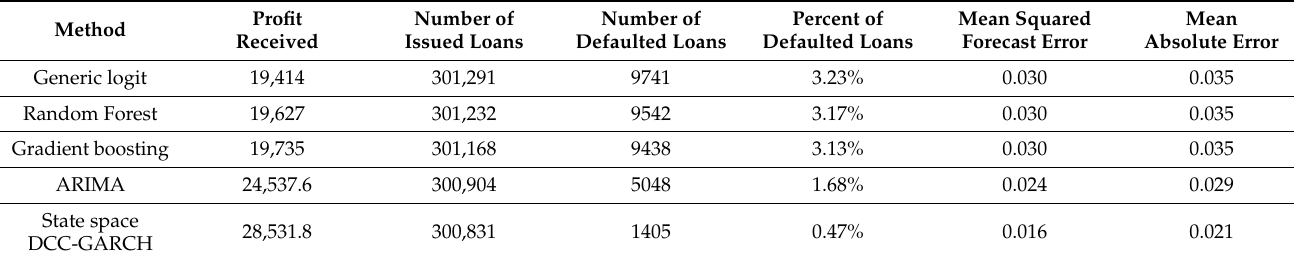
Table 2. The numerical forecasting results of proposed models and other ML approaches.